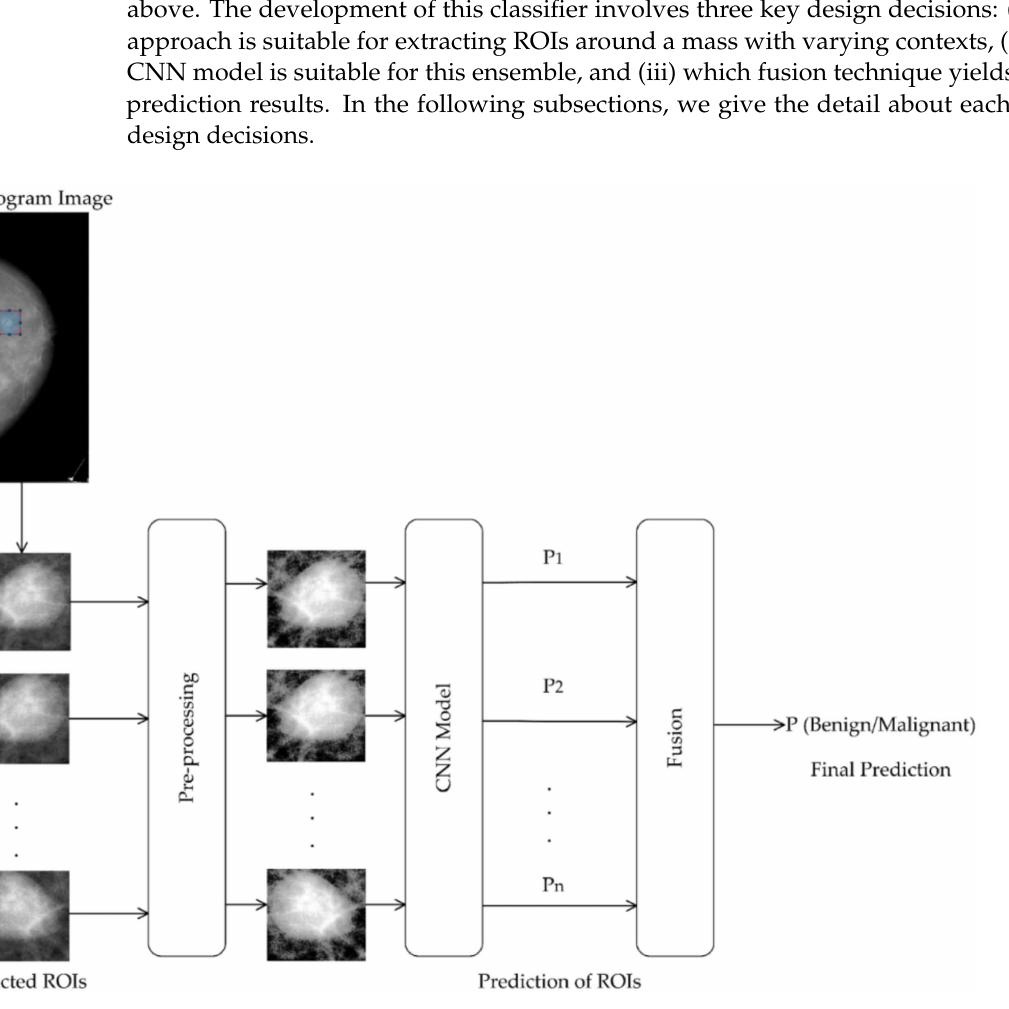
Figure 1. Proposed mammogram classification